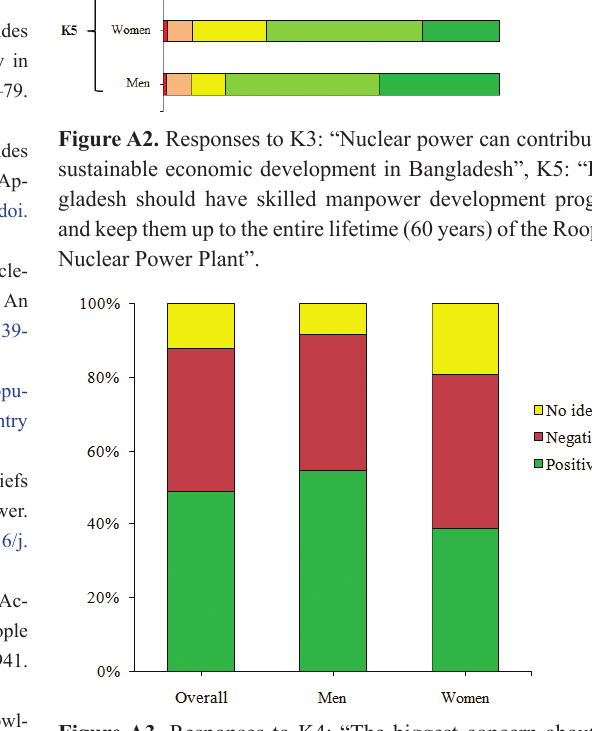
Figure A3. Responses to K4: “The biggest concern about the Rooppur Nuclear Power Plant